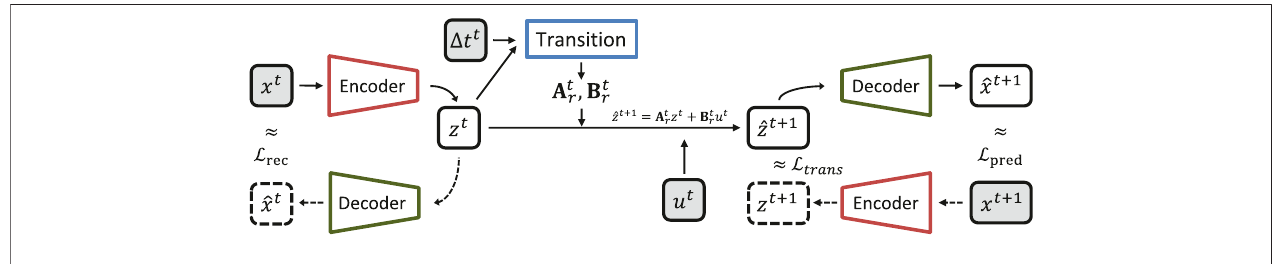
FIGURE 2 | Diagram for training the E2C — Embed to control